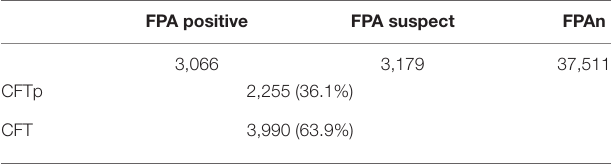
tABLe 2 | Comparison of numbers of responders between fluorescence polarization assay (FPA) and Complement Fixation Test (CFT) among serum samples randomly taken at early stages of the 2016 campaign.